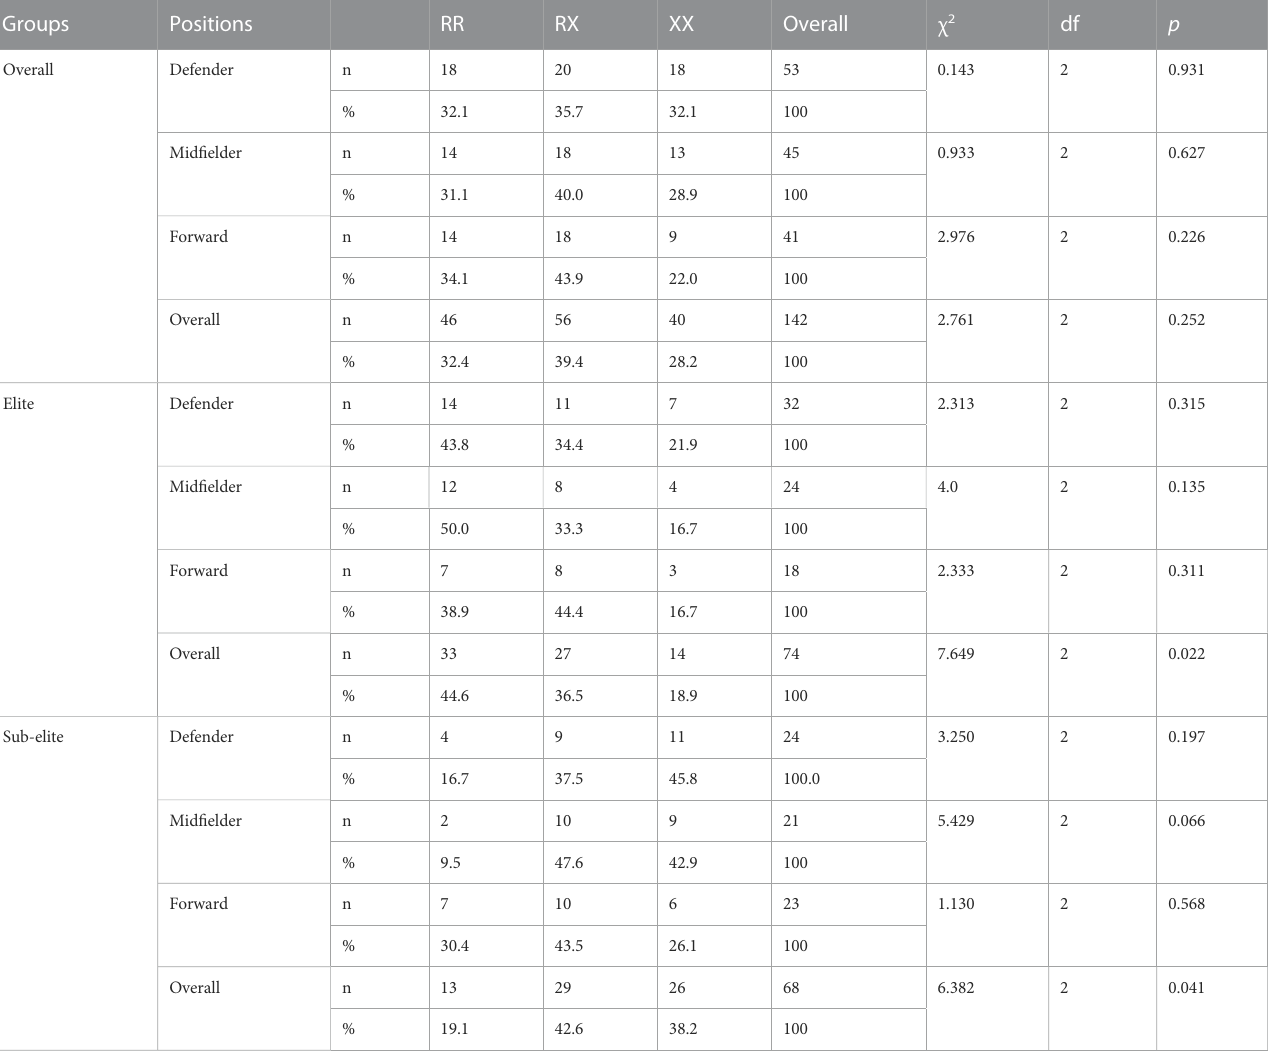
TABLE 2 The comparison of genotype frequencies in each elite and sub-elite goalkeeper, defender, mid fi elders and forward player. Groups Positions RR